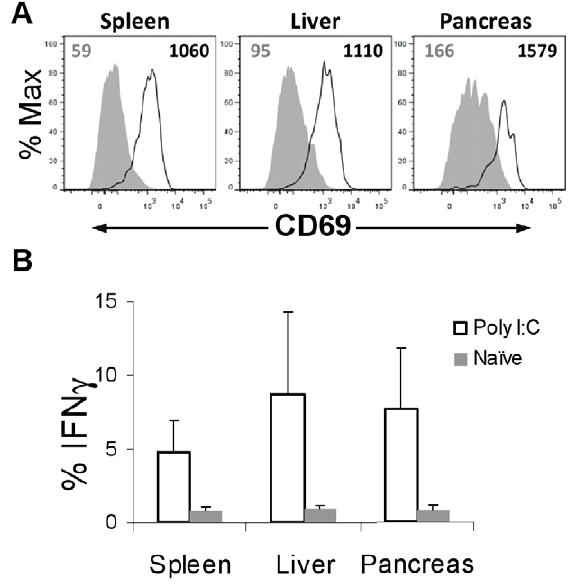
Figure 5. Invivo activation of pancreatic NK cells is intact. A) CD69 expression on NK cells from NOD mice injected with 200 m g poly I:C (solid line) versus control NOD mice injected with PBS (filled histogram). Colored numbers matching the respective histograms indicate median fluorescence intensity. One representative experiment of three independent experiments is shown. B) NK cells harvested from the mice in (A) were immediately stained ex vivo (without any in vitro stimulation) for intracellular IFN c . Results were combined from 3 independent experiments.